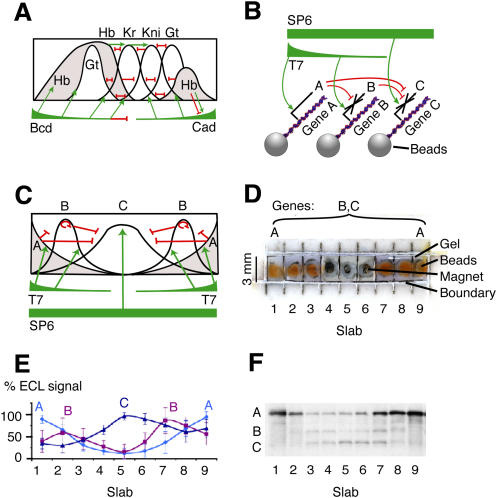
Gene Circuits and Chambers(A) Principal interactions in the Drosophila gap gene network, modelled after [37]. Relative levels and distributions of Hunchback (Hb), Giant (Gt), Krüppel (Kr), Knirps (Kni), Bicoid (Bcd), and Caudal (Cad) shown from anterior (left) to posterior (right). Green arrows indicate activation, red T-bars repression.(B) Artificial gene network design, with transcription activators T7 and SP6 polymerases, and zinc finger repressors A, B, and C. Genes are immobilised on paramagnetic beads, and T7 forms a directional concentration gradient.(C) Principal interactions in a simple designed network.(D) Transcription-translation chamber. Genes for repressor A are localised at the “poles,” whereas B and C are ubiquitous. Gel slabs 4–6 have been excised, exposing the magnets below, illustrating gel dissection for Western blot analysis.(E) Normalised Western data for four replicate chambers, showing mean levels of A, B, and C after 20 min (± One standard deviation).(F) Sample Western blot from the four-replicate experiment.